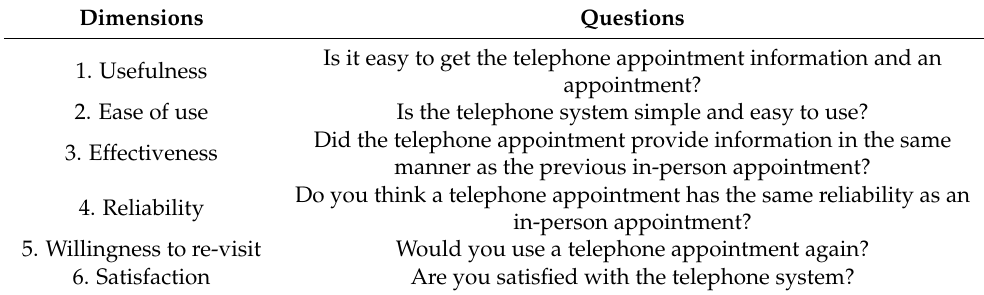
Table 1. The telehealth usability questionnaire (TUQ) of TCVGH 1